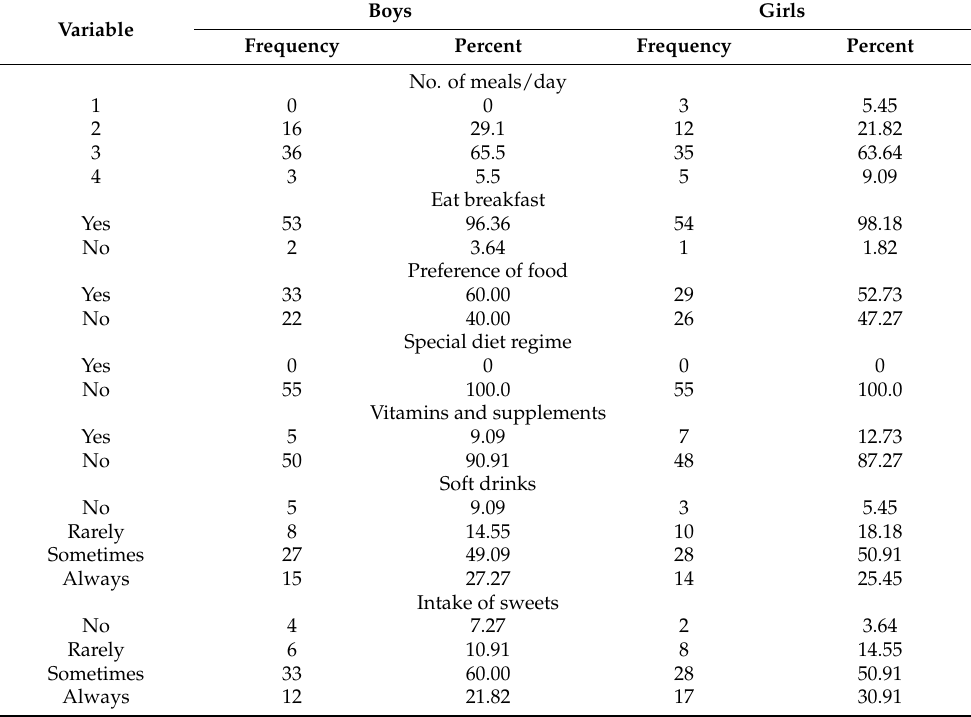
Table 2. Frequency distribution of Syrian participants (boys and girls) according to food